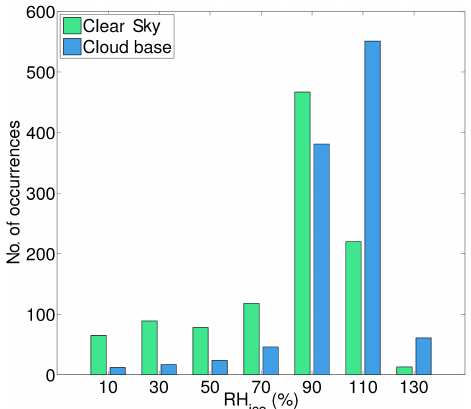
Fig. 9. RH ice measurements of radiosondes for clear-sky sample (green bars) and cloud-base sample (blue bars). For clear sky the same height distribution was followed as for cloud base. See text for more